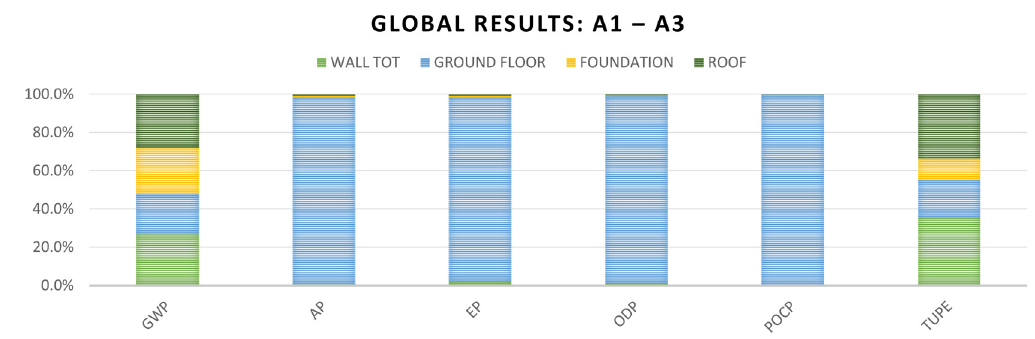
Figure 10. LCIA results: incidence percentages in each impact category.